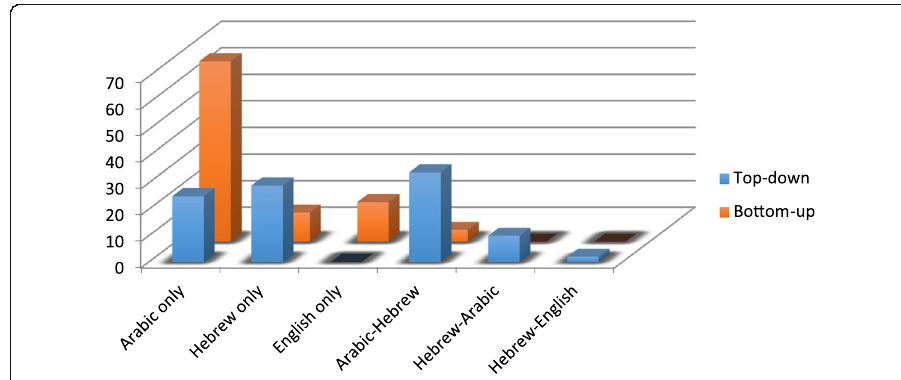
Fig. 8 Top-down vs. bottom-up schoolscape